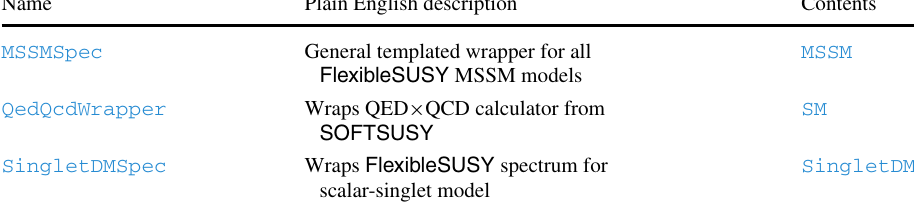
Table 13 List of available “simple” SubSpectrum wrappers, which wrap only parameter data and provide no RGE facilities, and they are therefore not connected to any backend spectrum generators. Spectrum data is either entered directly as input parameters or retrieved from an external source, such as an SLHA file. The final column ‘Contents’ gives the SubSpectrumContents definition (see Appendix C) to which the wrapper conforms Table 14 List of available “full” SubSpectrum wrappers, which connect directly to backend spectrum generator code and provide RGE-running facilities. The